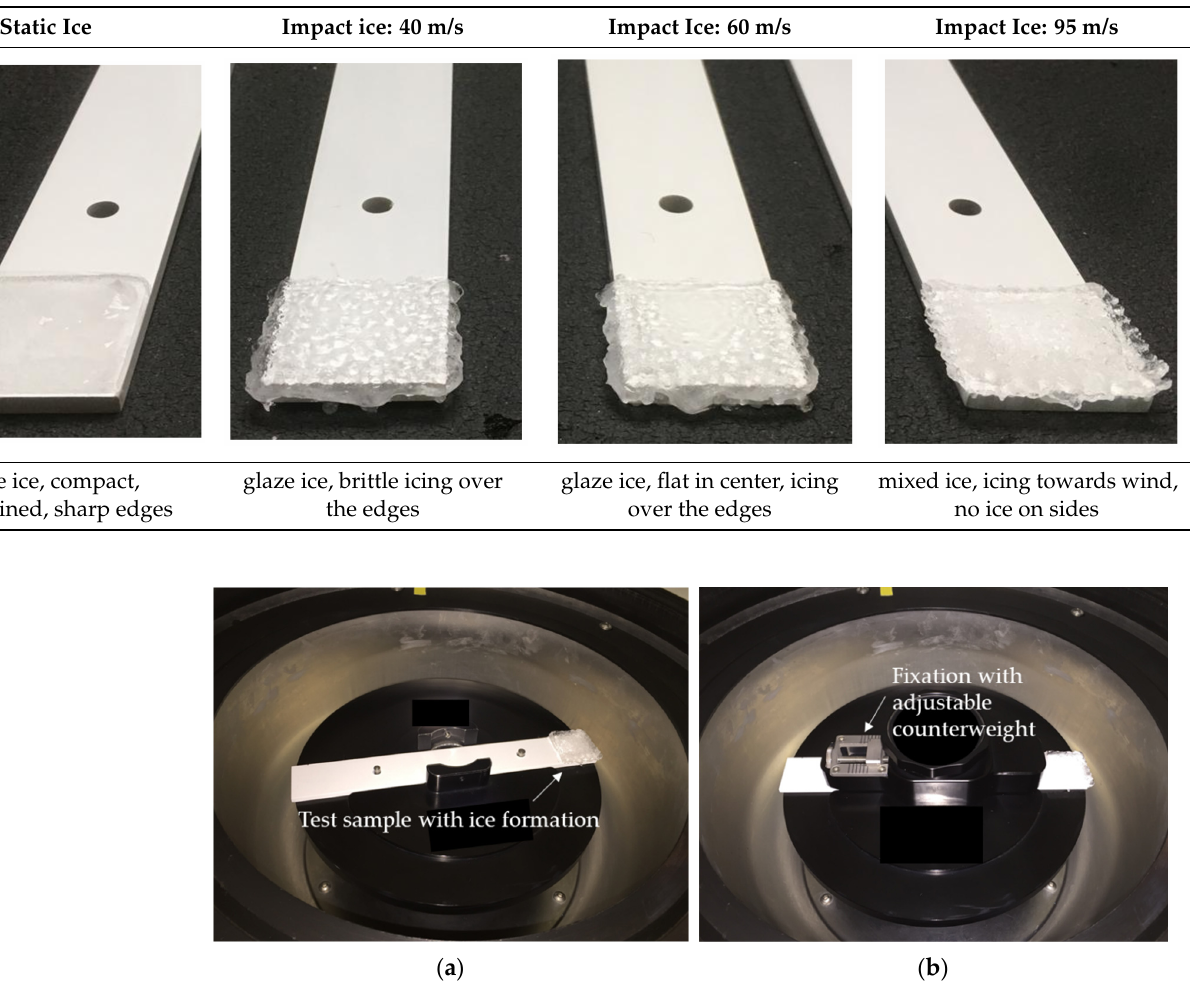
Figure 3. View inside the centrifuge test device with: ( a ) test sample with ice formation placed in the centrifuge; ( b ) test sample after fixation.